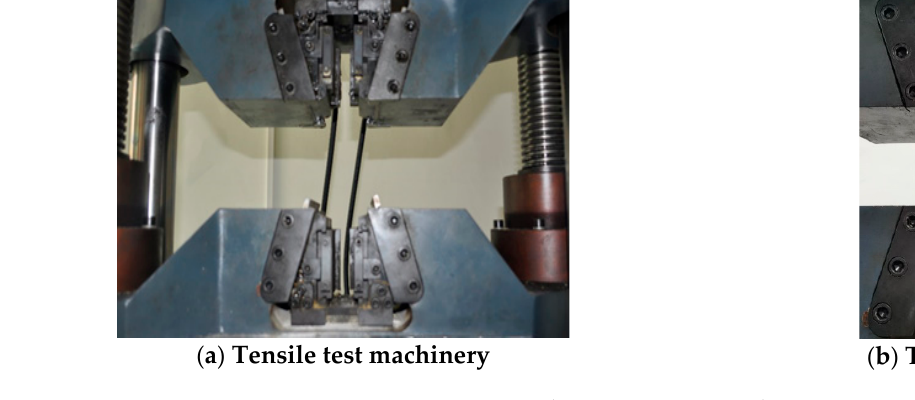
Figure 7. Tensile test instrument and process.